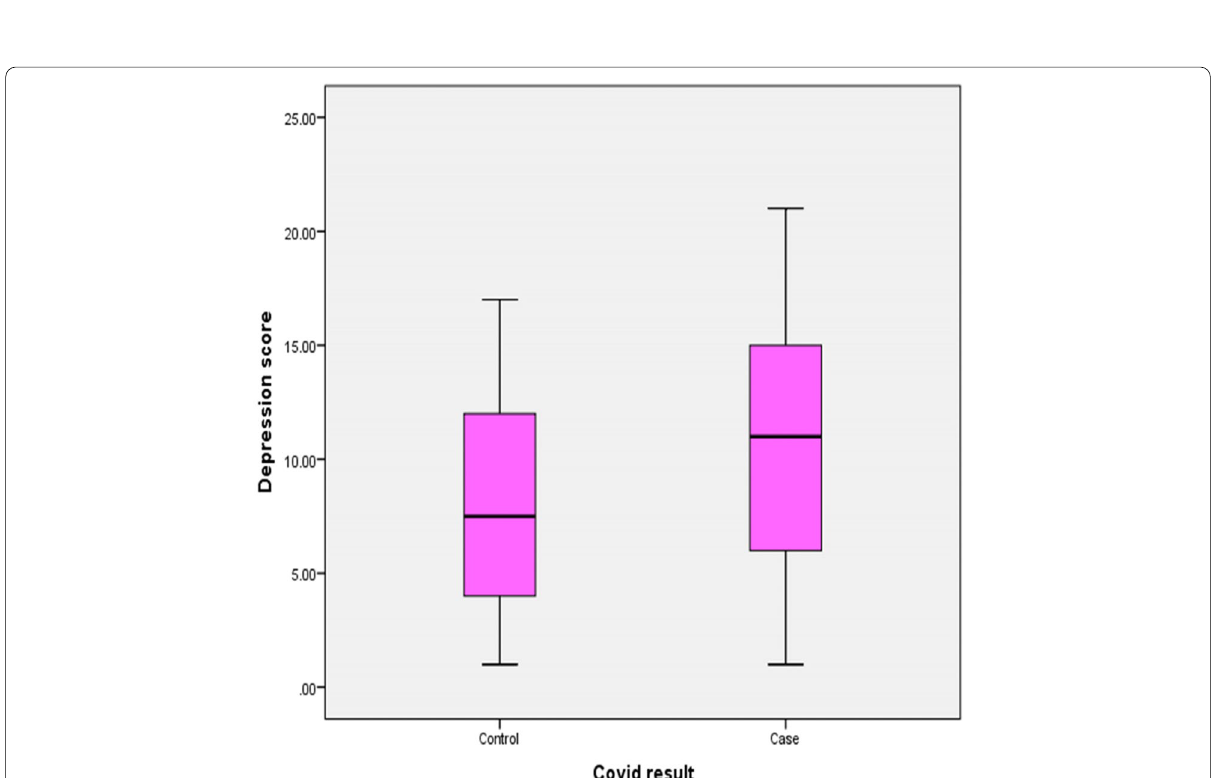
Fig. 2 COVID result: depression